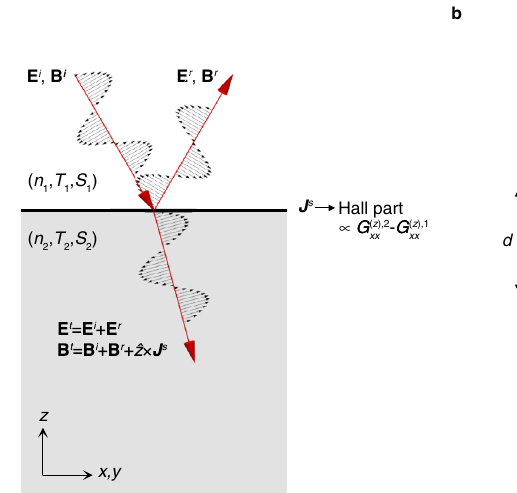
thatthelightpropagationisdescribedbyauniquerefractiveindexineachmedium. b Doubleinterfaces.In fi nitere fl ectionsoccurbetweenthetopandbottomsurfaces of medium 2. Light obtains the complex phase ϕ = kd = n 2 ω d / c while propagating the distance d in medium